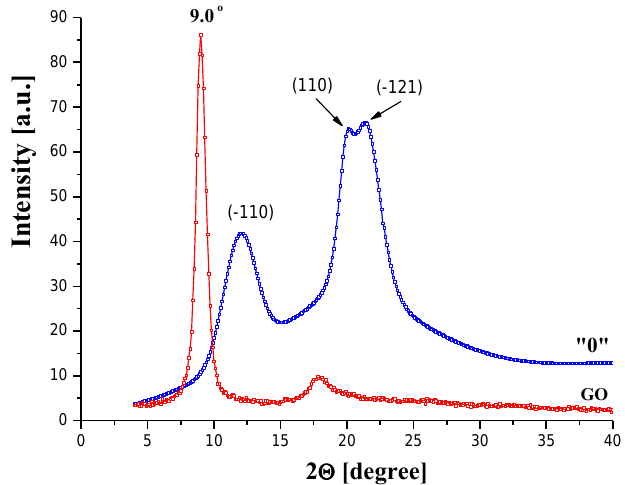
Figure 17. WAXS patterns of membrane “0” (pure cellulose) and pure GO.